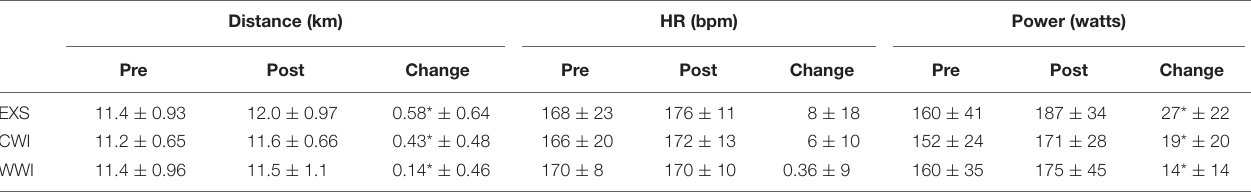
Values are means ± SD. Data are mean of pre and post-intervention work trial for each participant [Exercise (EXS n = 15)], Cold Water Immersion (CWI n = 14), Warm Water Immersion [WWI, n = 14)]. No significant difference between interventions. *Indicates significant main effect of time.